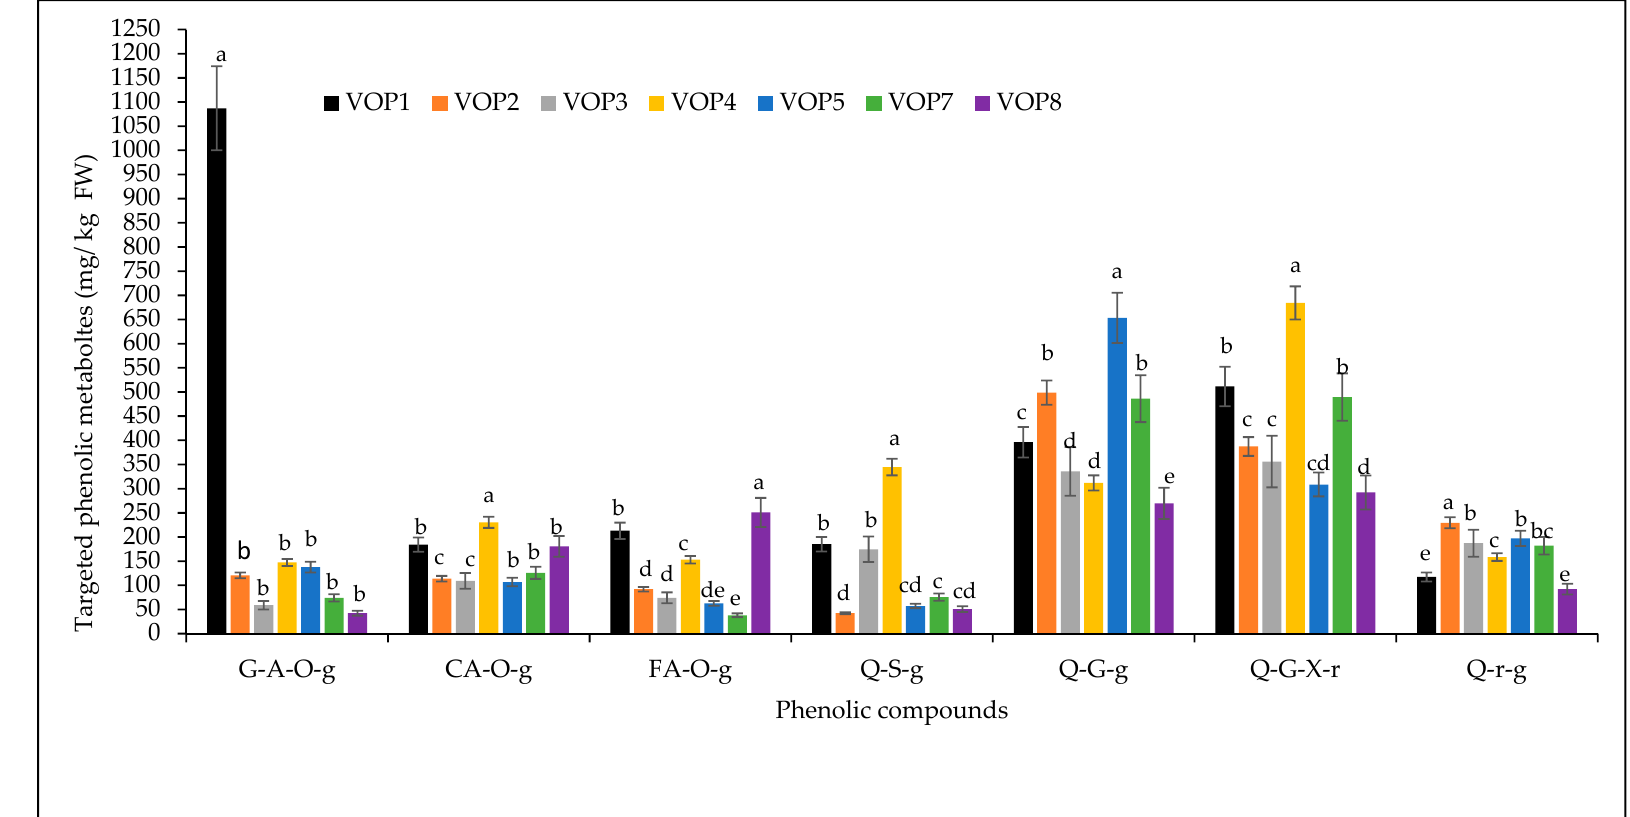
Figure 2. Concentration of targeted phenolic compounds in different cowpea cultivars. FW—fresh weight, Bar with same alphabets are not significantly different between cultivars at p < 0.05 for a specific phenolic compound. Data obtained were subjected to analysis of variance (ANOVA) using the statistical programme. Each bar represents the mean and standard deviation ( n = 3). Gentisic acid 5- O -glucoside (G-A- O -g); p-Coumaric acid O -glucoside (CA- O -g); Ferulic acid O -glucoside (FA- O -g); Quercetin 3-sambubioside-3 ′ -glucoside (Q-S-g); Quercetin 3-glucosyl-(1->2)-galactoside (Q-G-g); Quercetin 3-(2G-xylosylrutinoside) (Q-G-X-r); Quercetin 3- O -rhamnoside 7- O -glucoside (Q-r-g).